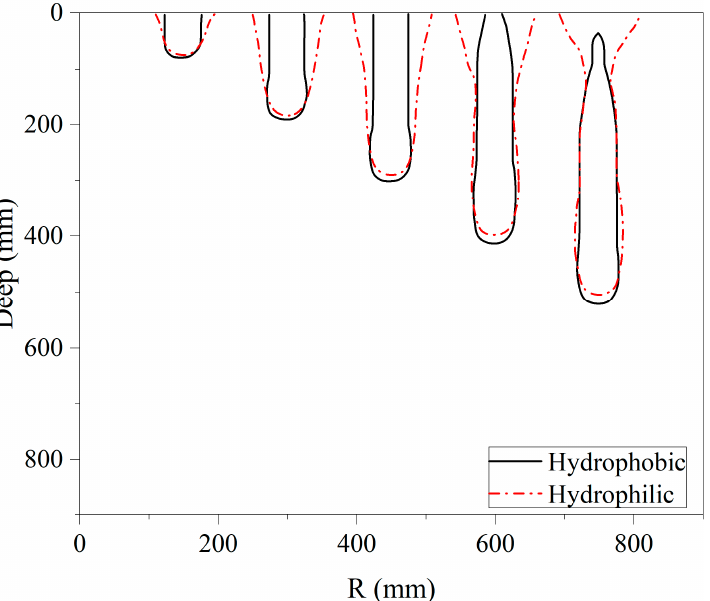
Figure 28. Comparison of the water entry vacuoles for the hydrophilic/hydrophobic model with a head shape hemispherical angle of 90° (the water entry times from left to right in the figure are 20, 40, 60, 80, 100 ms).